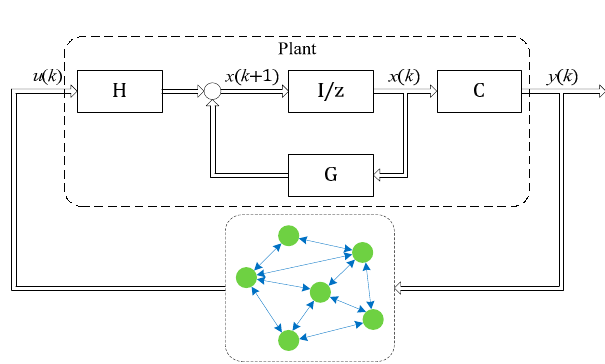
Figure 5. The networks acts as the output feedback controller.